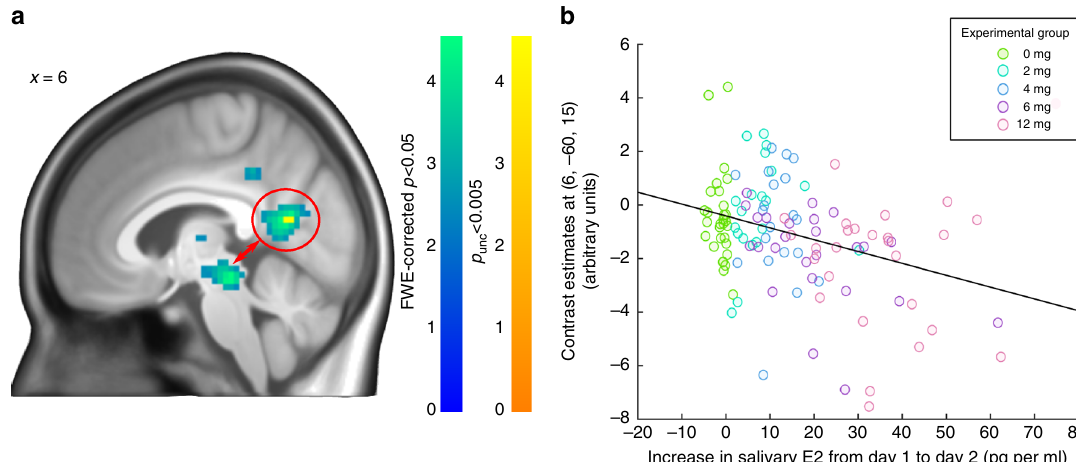
Fig. 6 Relationship between E2 increase and the negative > neutral contrast. a Statistical t-map of the negative linear relationship between salivary Day 1 to Day 2 increase in 17-beta-estradiol (E2) and the negative > neutral contrast ( N = 121). The statistical map is thresholded at FWE-corrected p < .05 (warm color scale) and p unc < .005 (cold color scale) for visualization purposes. Activity in a cluster in the right precuneus [circled in red; FWE-corrected p = .034; t -test] showed a negative linear relationship with salivary E2 increase. A negative linear relationship in the brainstem was not signi fi cant ([FWE-corrected p = .056; t -test)). A psycho-physiological interaction (PPI) analysis (seed: precuneus cluster, region of interest: brainstem cluster) revealed a negative linear relationship between E2 levels and precuneus-brainstem connectivity. b Robust regression analysis between contrast estimates (y-axis), extracted from the peak of the precuneus cluster, and salivary E2 levels (x-axis) con fi rmed the negative linear relationship. Colors represent experimental